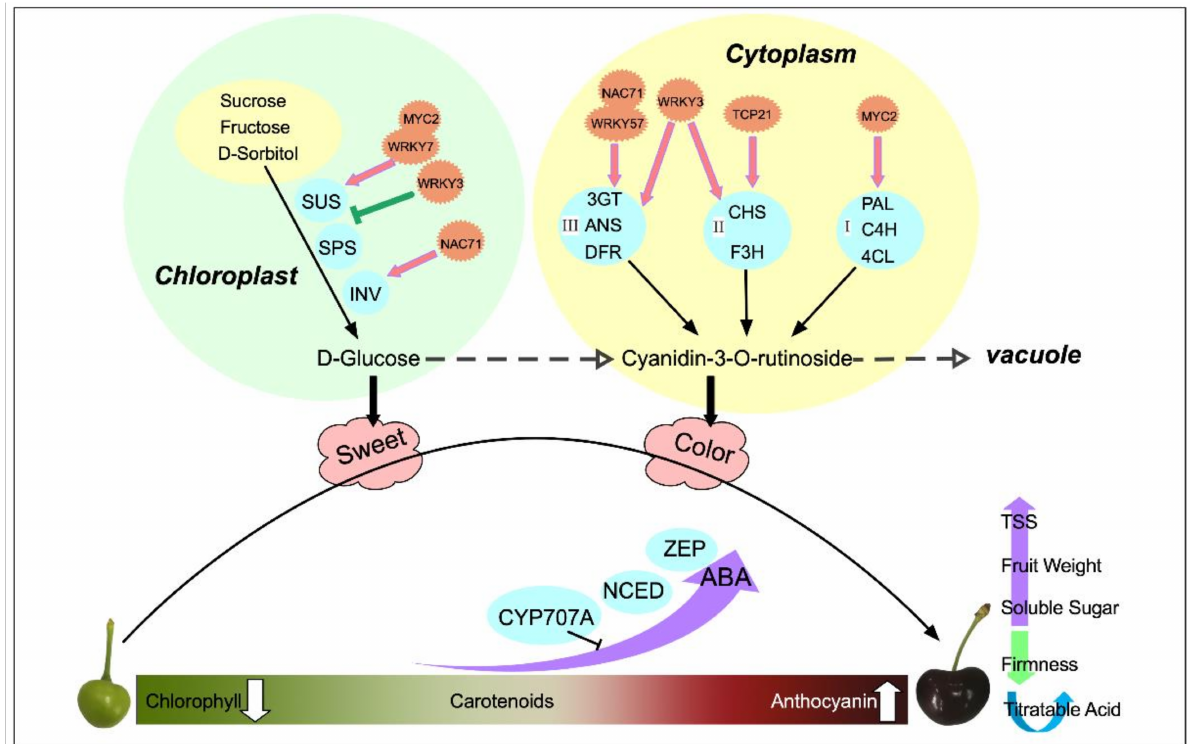
Figure 11. Schematic diagram of quality changes and regulation during the natural development of sweet